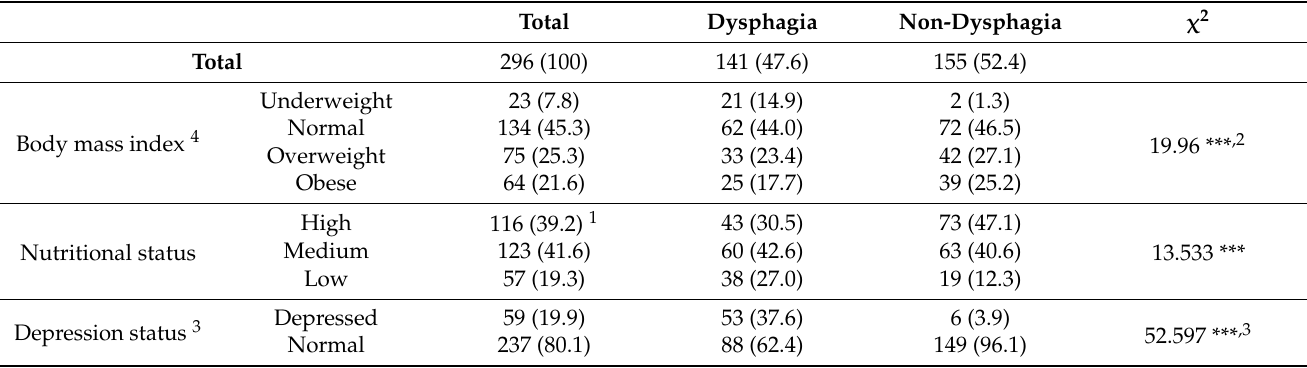
Table 5. Body Mass Index, Nutritional Status, and Depression Status by